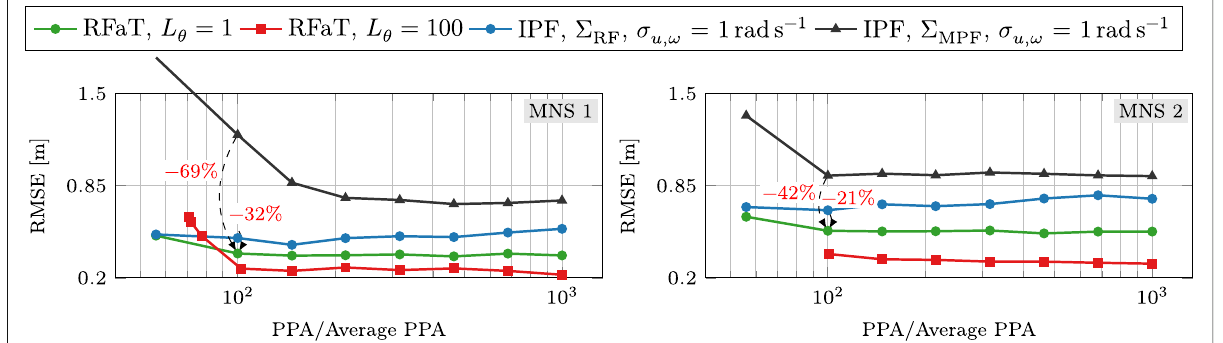
but an otherwise identical configuration. The boxplots on darker gray backgrounds are based on a reduced target edge length l ϕ for the mean mesh, where a smaller value of l ϕ indicates that the number of mean-modeling vertices used, N β , is larger. In this case, the number of vertices is increased from N β = 19 ( l ϕ = 3.5) to N β = 29 ( l ϕ = 2.5). In Fig. 12a, the RMSE performance is depicted whereas Fig. 12b shows the RFE performance.